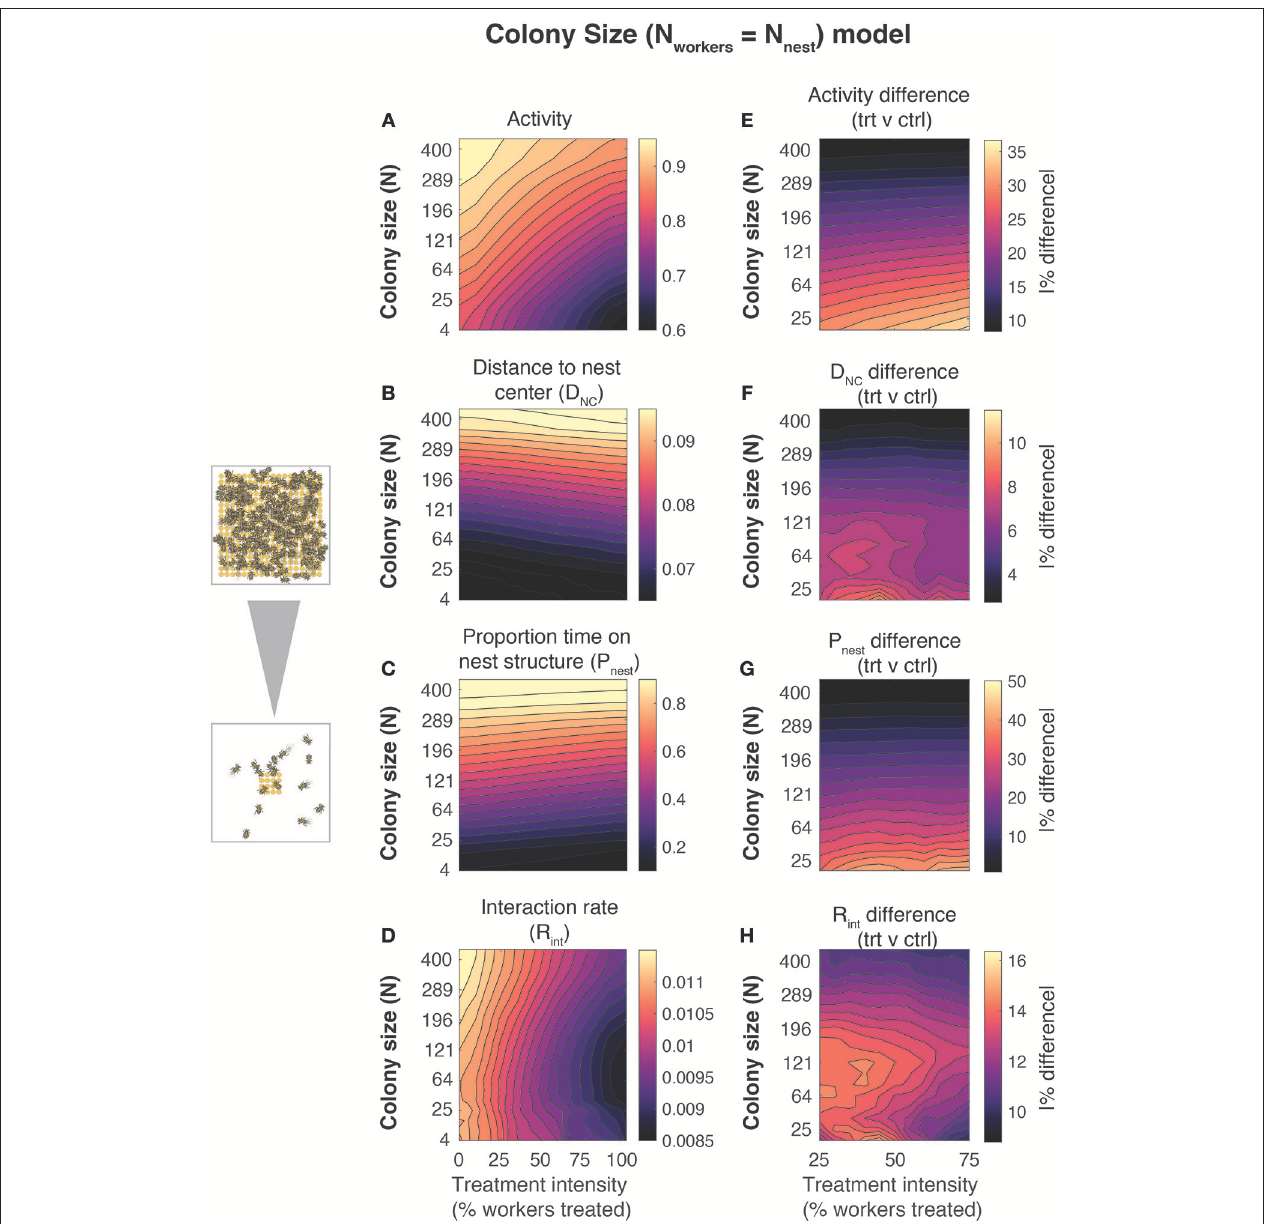
FIGURE 2 | Effects of colony size on emergent behavior in bumblebee nests. Mean behavioral metrics (left column) and relative differences between treated and control workers (right column) as a function of colony size and treatment intensity (% of workers treated). Data are shown for four metrics: (A,E) activity, (B,F) distance to the nest center (D NC ), (C,G) proportion of time spent on the nest structure (P nest ), and (D,H) interaction rate (R int ). Values are the mean across all workers and replicate simulations at a given parameter set. The number of simulation iterations at each parameter set was varied with colony size (# of iterations = 10000/ N, where N = # of workers). Phase spaces smoothed using local averaging over adjacent values (smoothing window: ± 10% for treatment intensity, (sqrt(N-2)) 2 :(sqrt(N + 2)) 2 for N nest /N workers ). For all simulations, the number of nest structure elements (N nest ) and the number of workers (N workers ) were varied simultaneously to maintain a 1:1 nest structure: worker ratio. Differences between control and treated workers (right column) were calculated as a percentage of mean absolute value, abs([ trt – ctrl ]/mean( trt , ctrl )])*100, where trt denotes the treated workers and ctrl denotes the control